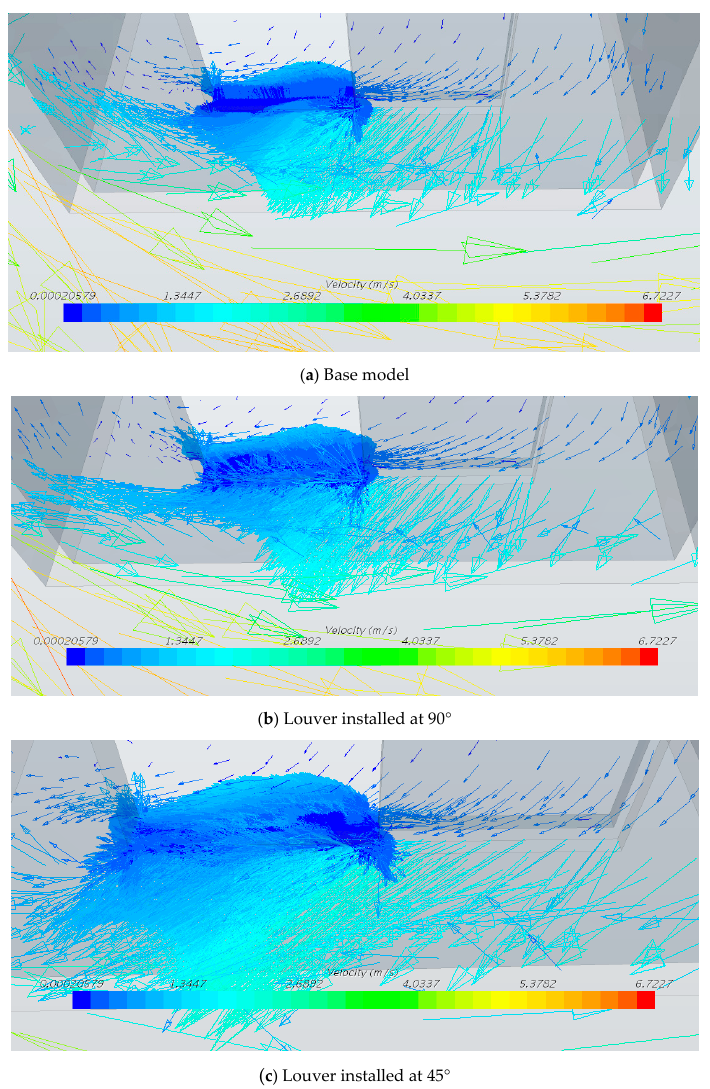
Figure 13. Result of the installation angle setting simulation. ( a ) Base model, ( b ) Louver installed at 90°, ( c ) Louver installed at 45°.